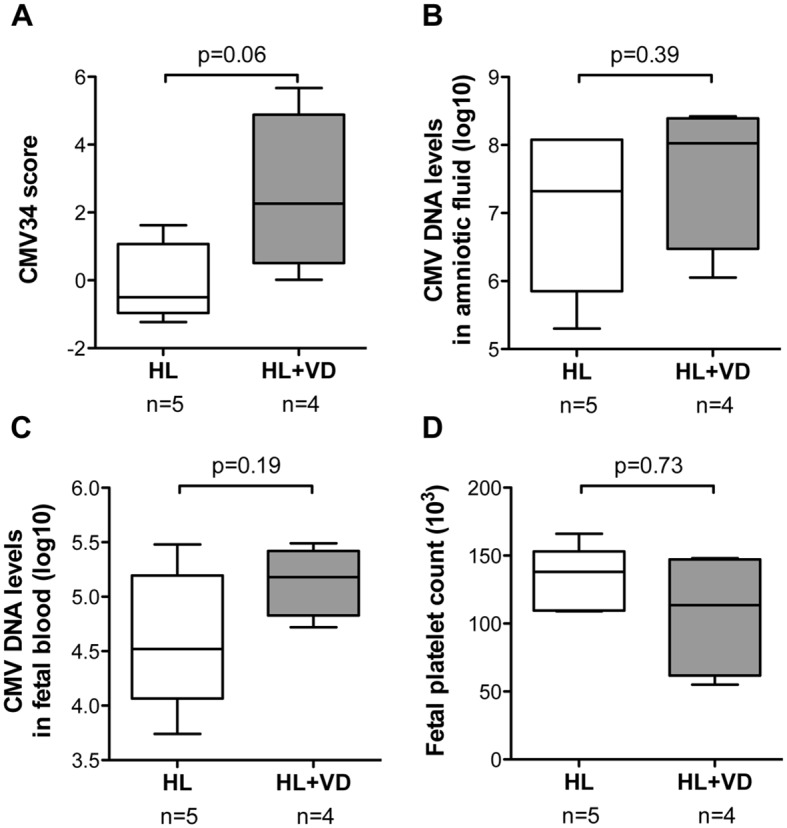
Classification of primary CMV infection with moderately symptomatic neonates.(A) The amniotic fluid peptide content of CMV-infected fetuses with moderate neonatal symptoms (hearing loss (HL) or hearing loss and vestibular dysfunction (HL+VD)) was scored with the CMV34 classifier. The scores allowed a nearly significant difference after analysis by Mann-Whitney test for independent samples (p = 0.06). CMV DNA levels in amniotic fluid and fetal blood (B and C, respectively) and the fetal platelet count (D) were clearly not different between hearing loss versus hearing loss and vestibular dysfunction (p values of 0.32, 0.19 and 0.73, respectively, Mann-Whitney test for independent samples).